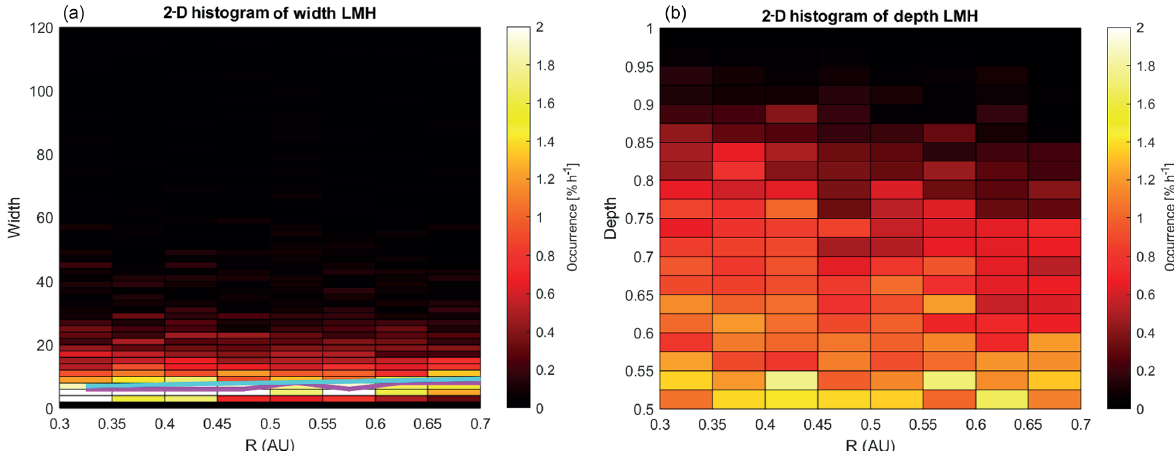
Figure 7. 2-D histogram of the occurrence rate of (a) the width (in seconds) and (b) the depth of the LMHs as a function of radial distance from the Sun. In panel (a) the green line shows the maximum occurrence rate in each radial bin and the cyan line shows the increase in width of LMHs as observed by Sperveslage et al.